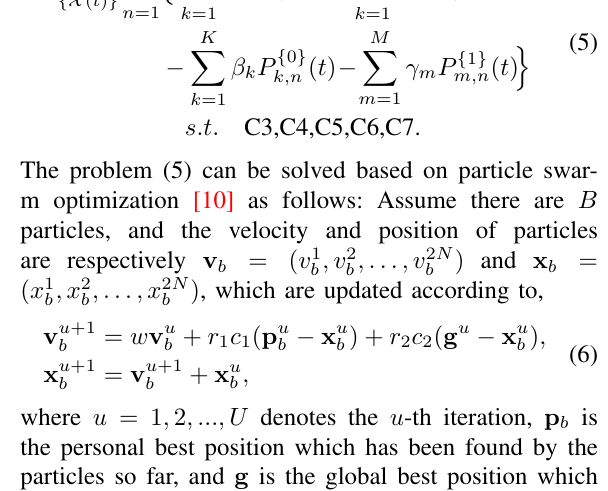
Algorithm 1 The MSRAP scheme at slot t